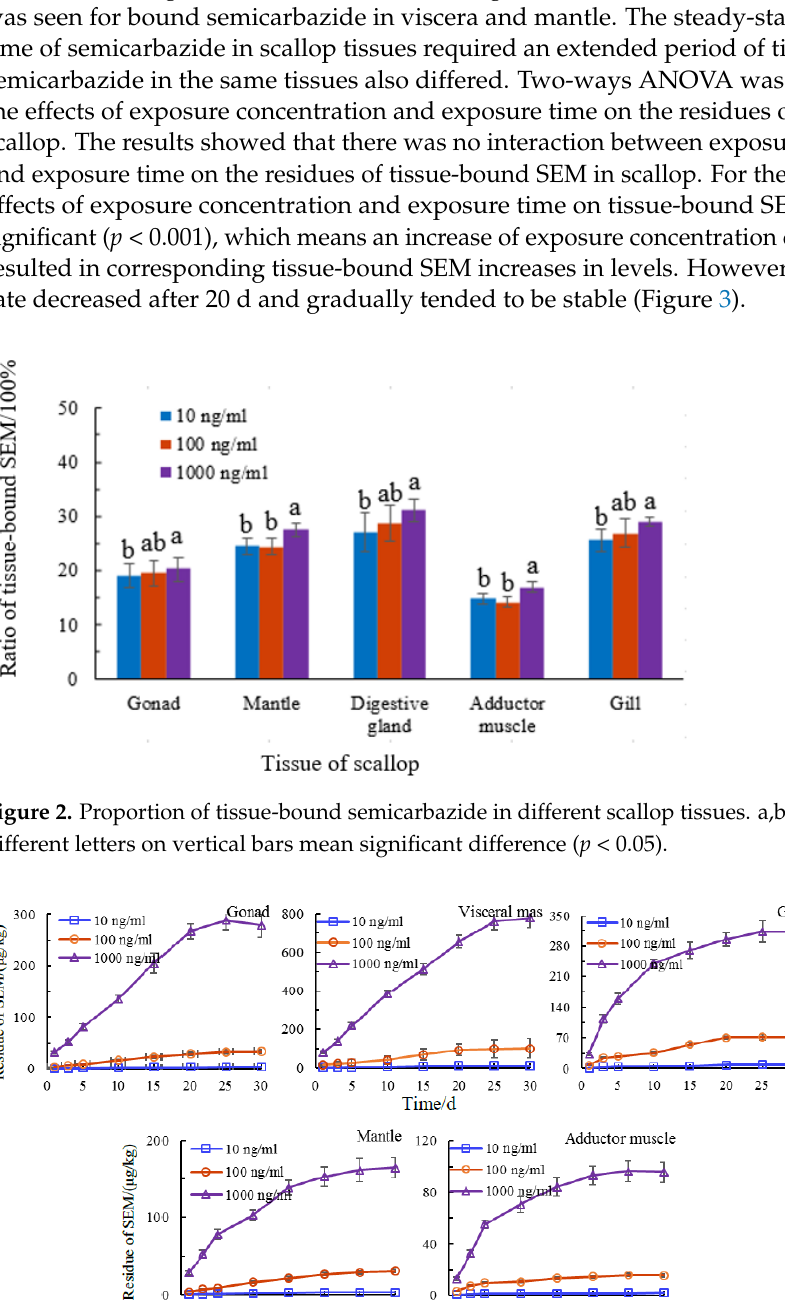
Figure 3. Ci - Ti of tissue-bound semicarbazide residue in scallop with exposure time.